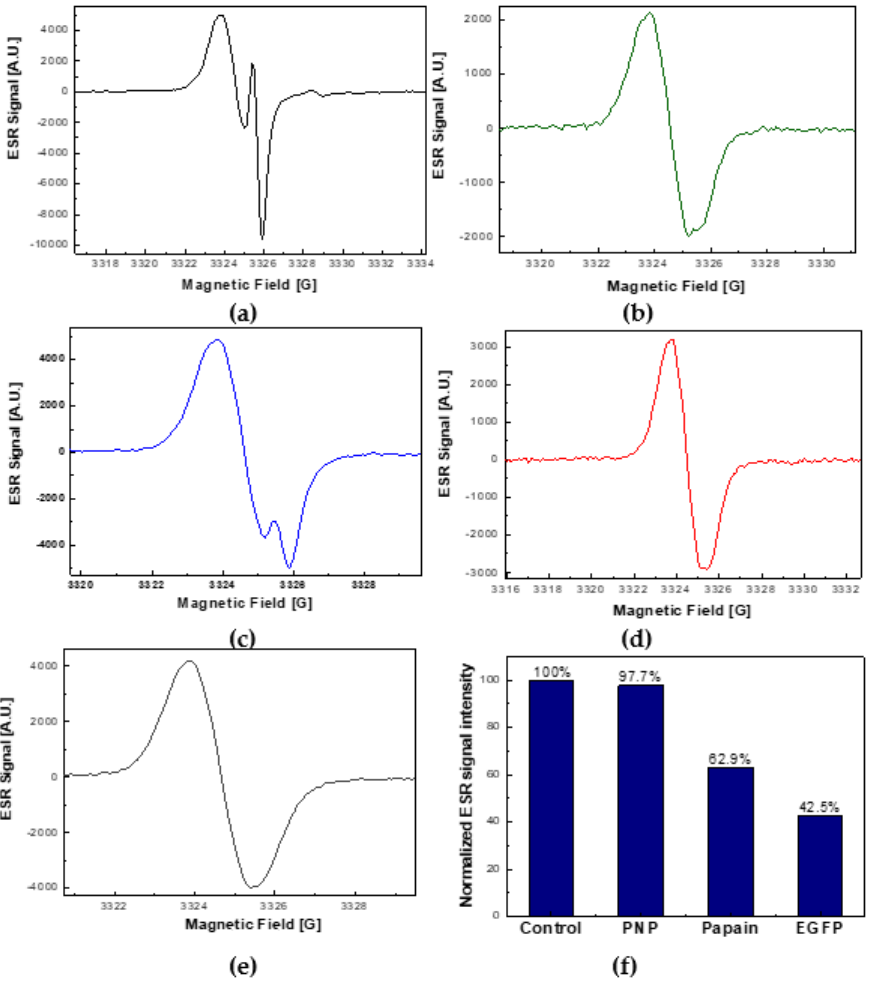
Figure 6. Comparison of the ROS quenching capacity of three proteins, PNP, papain, and EGFP, during the photosensitized generation of singlet oxygen ( 1 Δ g ) and superoxide radicals (O 2•− ) by 50 μM rose bengal exposed to visible light. Under the action of photosensitized ROS, the spin-trap TMP-OH (50 mM) is converted to the ESR-active nitroxide radicals, TEMPOL and TEMPONE. ( a ) The low-field hyperfine ESR feature acquired for the control measurement in the absence of proteins. ( b ) The low-field hyperfine ESR feature acquired in the presence of 40 μM EGFP. ( c ) The low-field hyperfine ESR feature acquired in the presence of 40 μM PNP. ( d ) The low-field hyperfine ESR feature acquired in the presence of 32 μM papain. ( e ) The low-field hyperfine ESR feature collected for a reference sample (50 μM TEMPOL). ( f ) Juxtaposition of the normalized ESR signal intensities recorded for the three tested proteins after 20 min of exposure to visible light. All ESR spectra were recorded using the same experimental settings (0.63 mW microwave power, 0.5 G mod., 4 scans per trace).